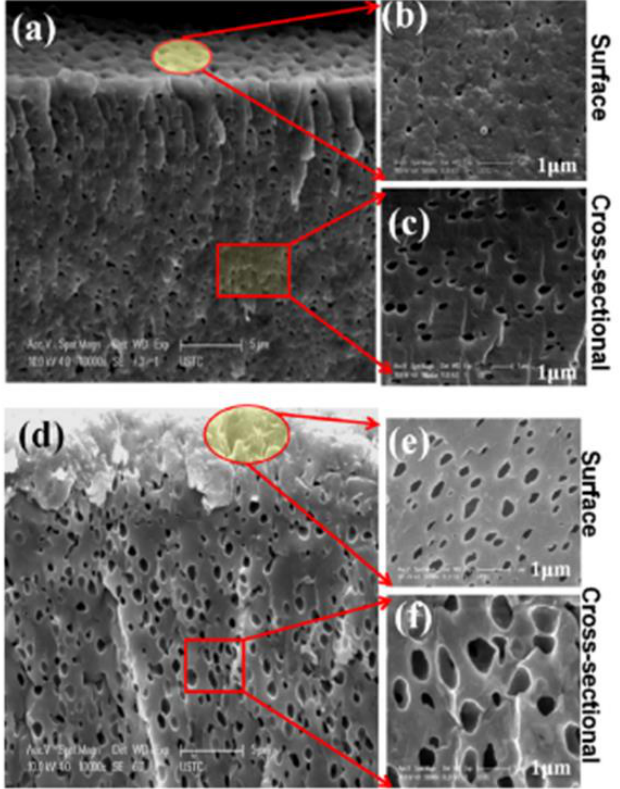
Figure 2. Scanning electron micrographs of porous AEM with ionic liquid: ( a – c ) corresponds to a low amount of ionic liquid, while ( d – f ) has a higher ionic liquid loading. Reprinted from Reference [53] with permission from Elsevier.